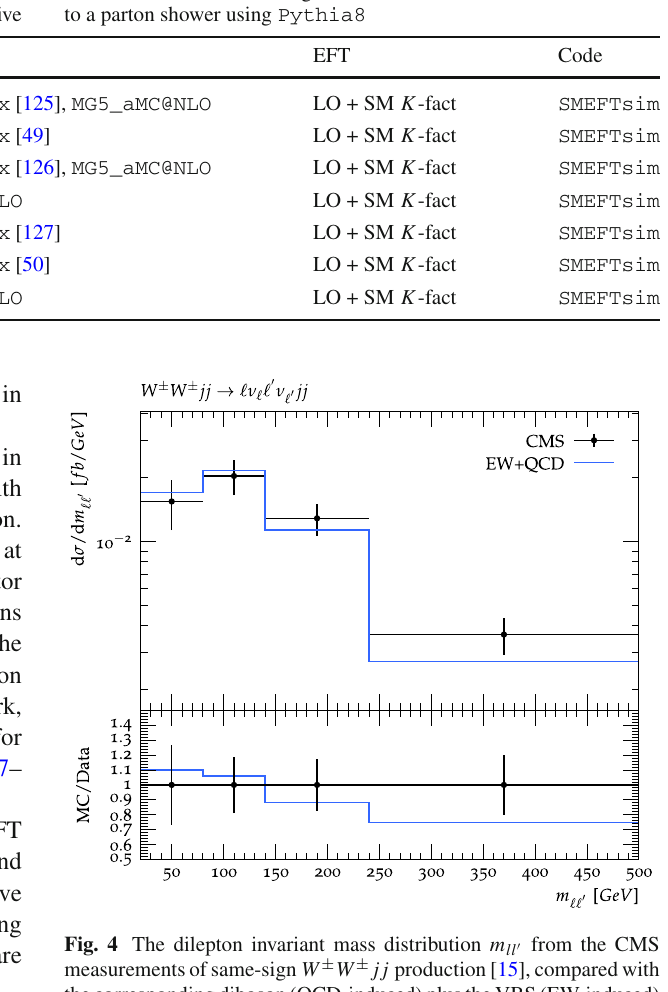
accuracy and the codes used to produce the corresponding predictions. All the simulations are first generated at fixed-order and then matched to a parton shower using Pythia8